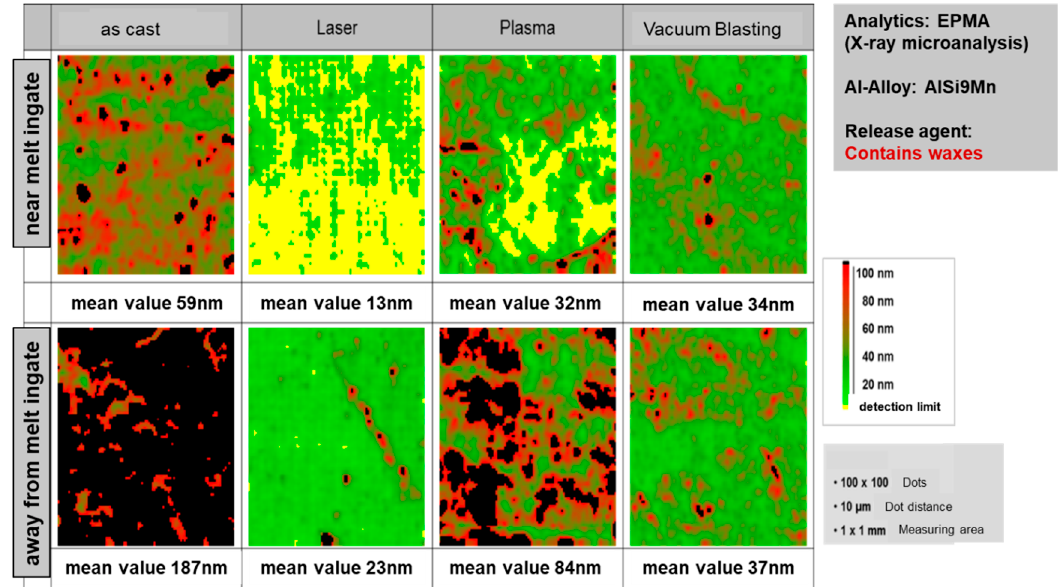
Figure 7. Laser pre-treatment is the most e ff ective to remove waxes from the surface of a die-cast aluminum surface.